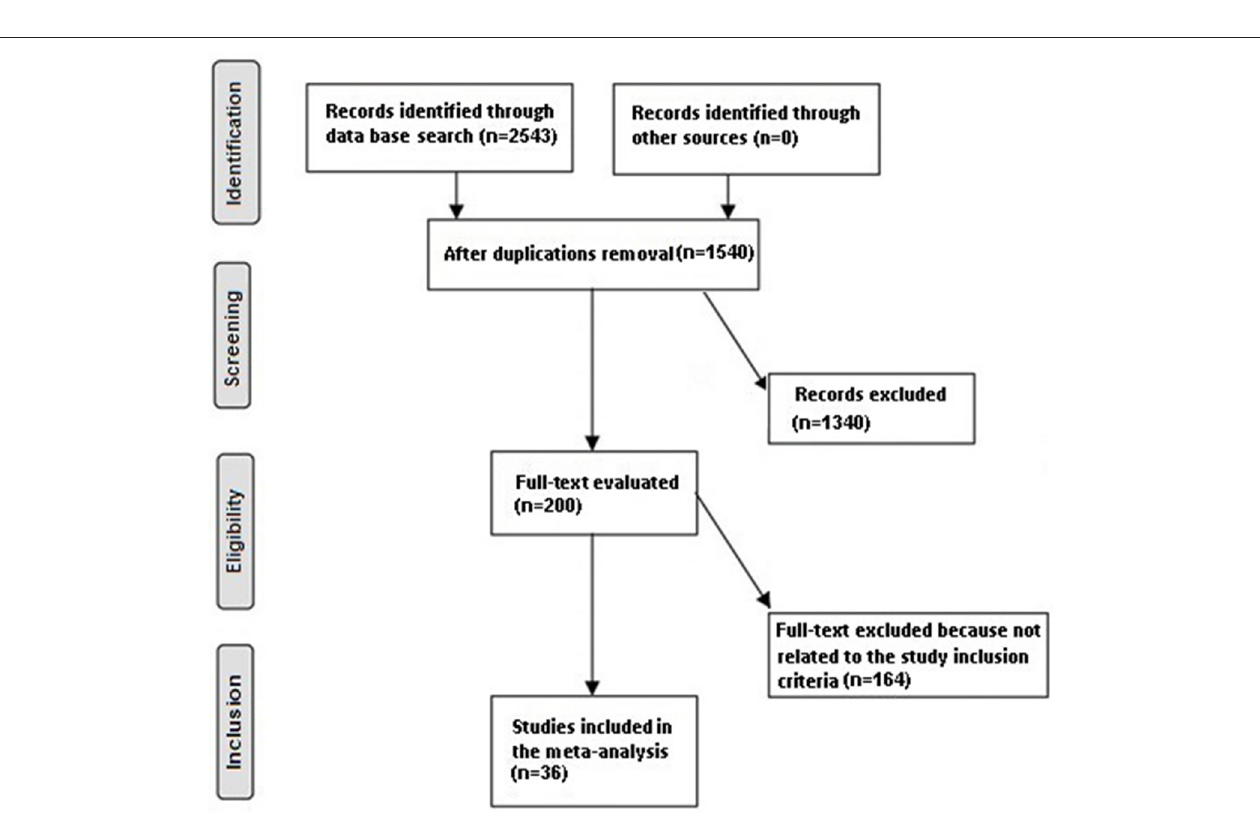
FIGURE 3 | Forest plot of the effect of open nephroureterectomy compared with laparoscopic nephroureterectomy on hospital stay in subjects with upper urinary tract urothelial carcinoma.